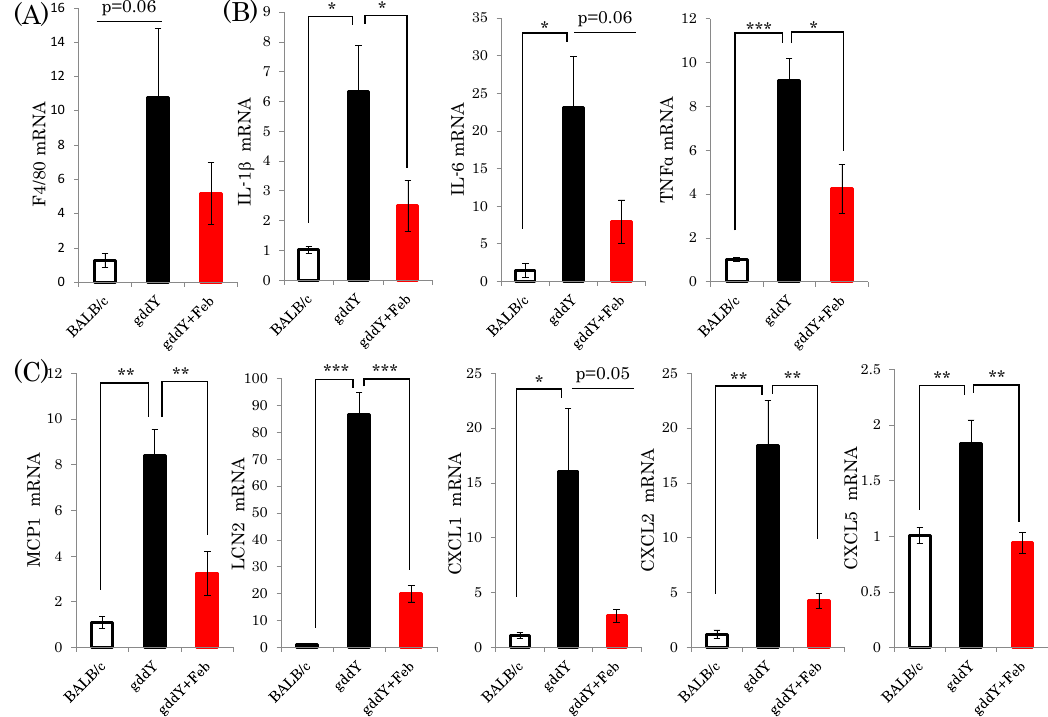
Figure 3. Febuxostat suppresses the expressions of both inflammatory cytokines and chemokines in the kidneys of gddY mice. ( A – C ) Relative mRNA levels of macrophage markers, cytokines, and chemokines in the kidneys were determined employing real time PCR (BALB/c control mice: n = 8, untreated gddY mice: n = 4, febuxostat treated gddY mice: n = 8) *: p < 0.05, **: p < 0.01, ***: p <